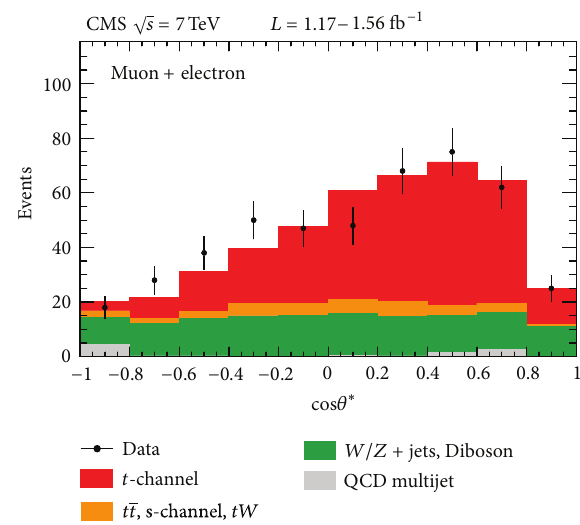
Figure 3: Distribution of cos 𝜃 ∗ ℓ in the |𝜂 𝑗 󸀠 | > 2.8 region, from